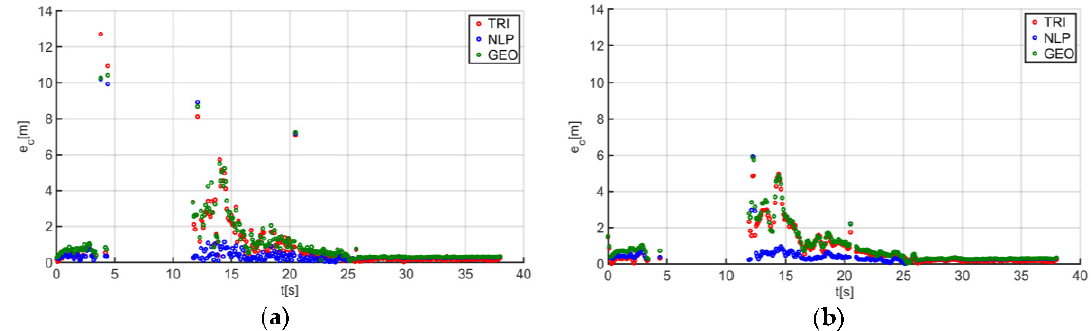
Figure 13. Comparison of the results of the total e c (t) location errors: ( a ) before final filtering and ( b ) after final filtering for trajectory no. 3.